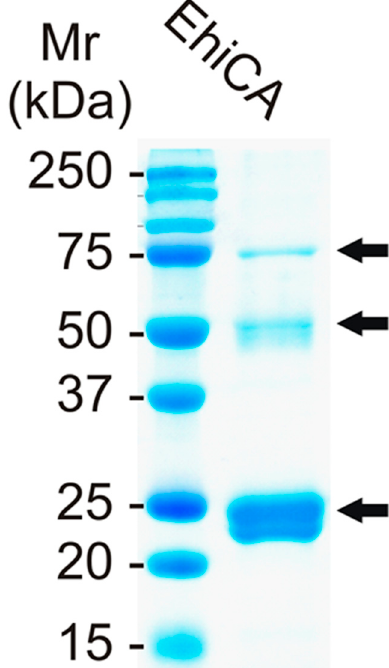
Figure 1. SDS PAGE of the β -CA from E. histolytica (EhiCA) showing a 21/25 kDa doublet polypeptide and additional polypeptides of about 50 and 75 kDa (arrows). Left lane: Standard Mw markers. The dimer and the trimer of EhiCA are also seen (arrows), as reported for other β -CAs cloned and purified earlier [11–15].